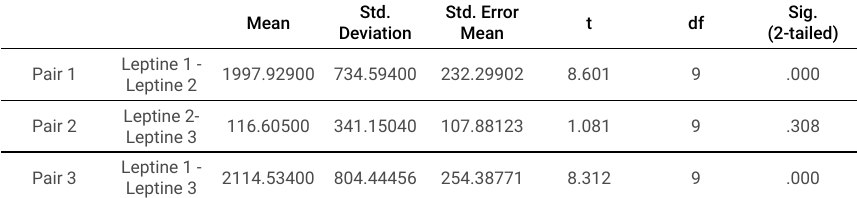
Table 3. Saliva leptin level differences between the three